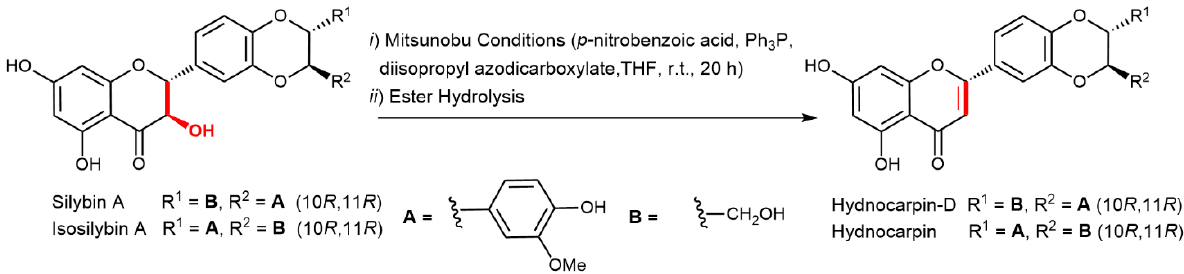
Figure 6. Example of hydnocarpin preparation from flavonolignans using Mitsunobu conditions [89]. A panel of C-23 derivatives of silybin A and B (sulfate, azide, phosphodiester, and amine) were prepared [91] to investigate the antioxidant behavior of both series of A and